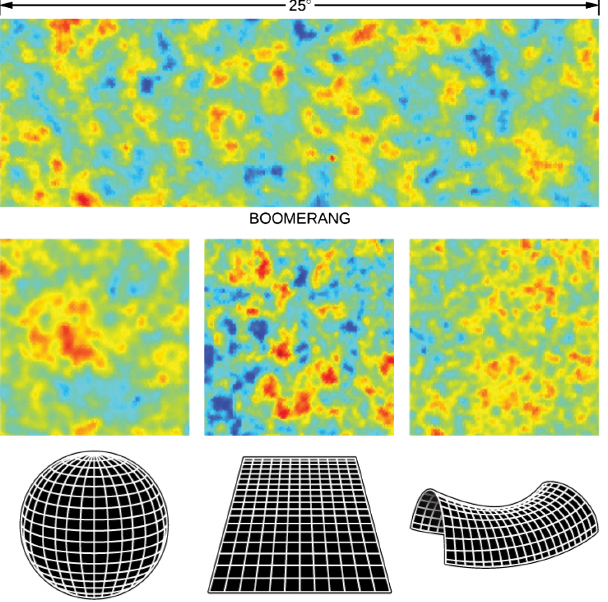
FIG. 32. An example of combination, using data generated representation, together with computer modeling, and the pos- sible geometries, seen in Fig. 13. Image credit: OpenStax Astronomy Textbook modification of work by NASA [102].